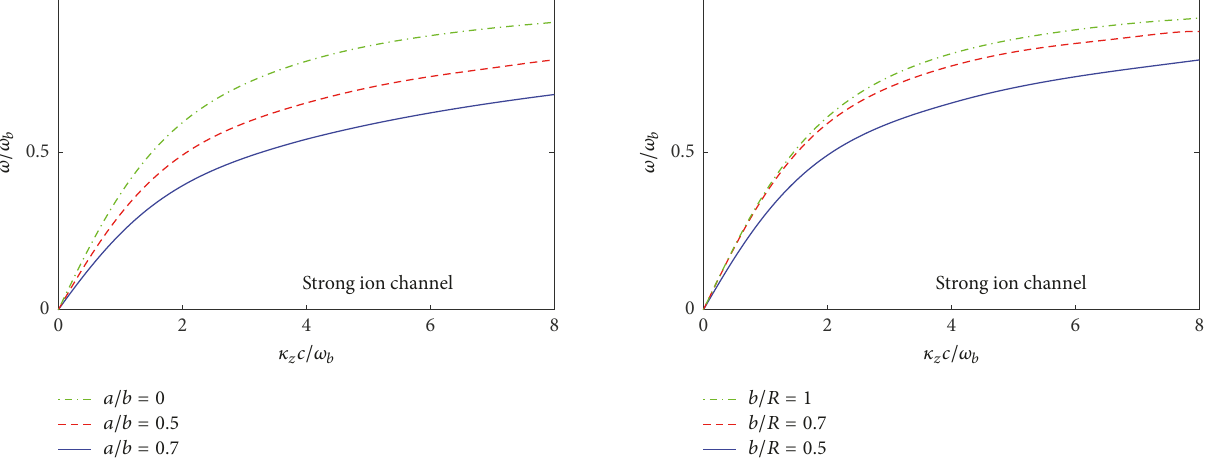
Figure 2: The influence of the ratio 𝑎/𝑏 on the dispersion curves of the SC 01 waves for strong ion channel with 𝜔 𝛽 = 2.3195 . The outer radius of the annular beam is taken as 0.5 R and 𝑎/𝑏 = 0 represents the solid beam case.